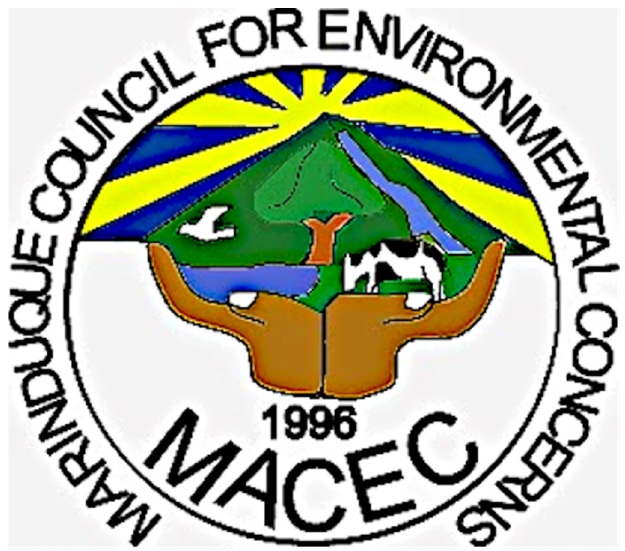
Figure 2. The original logo of MaCEC .